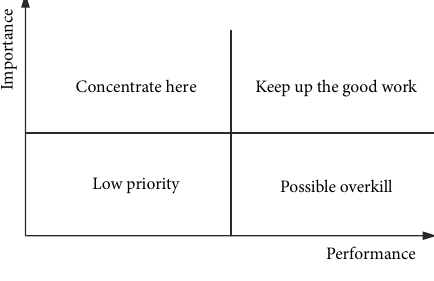
Figure 1. Four categories in standard